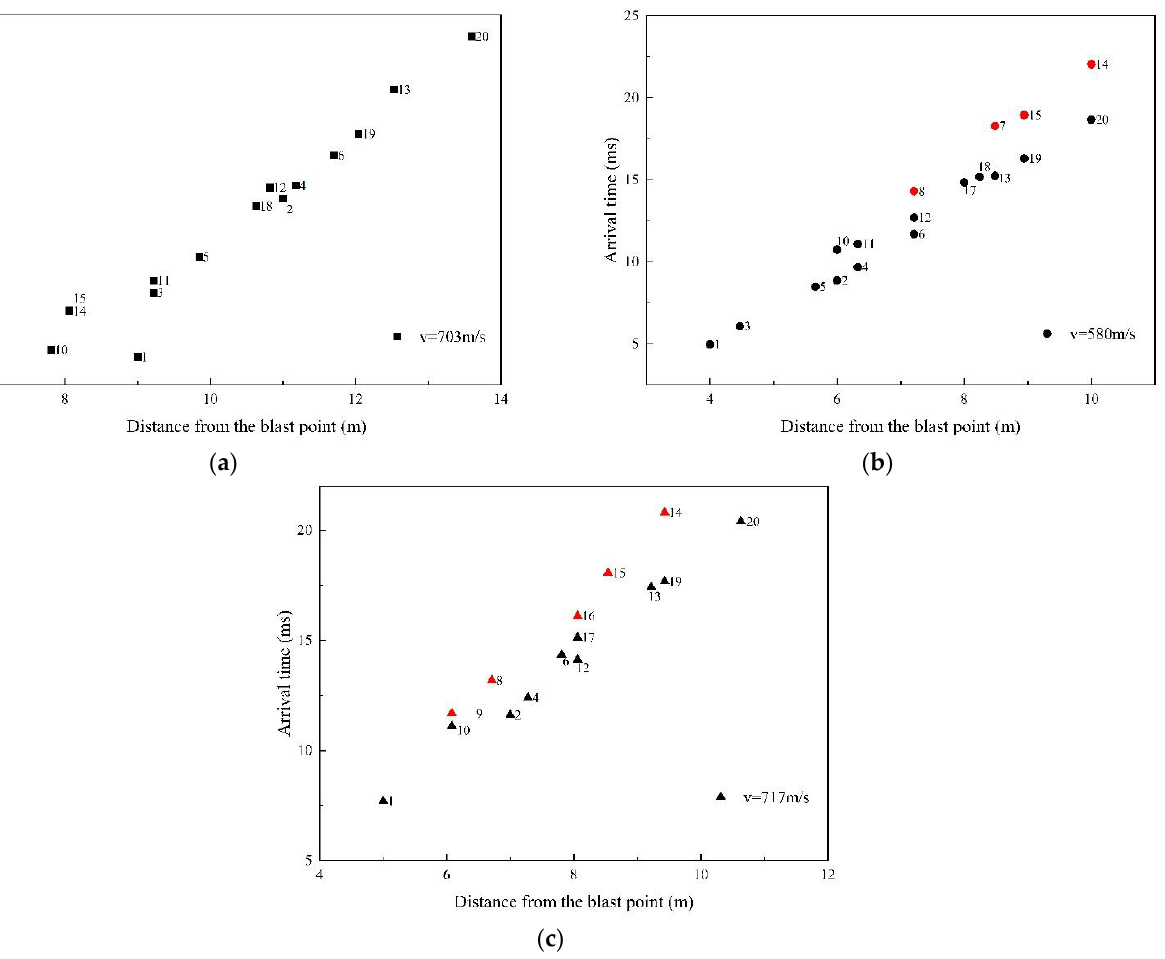
Figure 9. Arrival time at different measurement points from a moving charge explosion: ( a ) the speed was 703 m/s and the deviation was −3 m (in the opposite direction of the charge motion), ( b ) the speed was 580 m/s and the deviation was +2 m (in the positive direction of the charge motion) and ( c ) the speed was 717 m/s and the deviation was +1 m. The measurement points with a direction angle greater than 90° are marked in red.